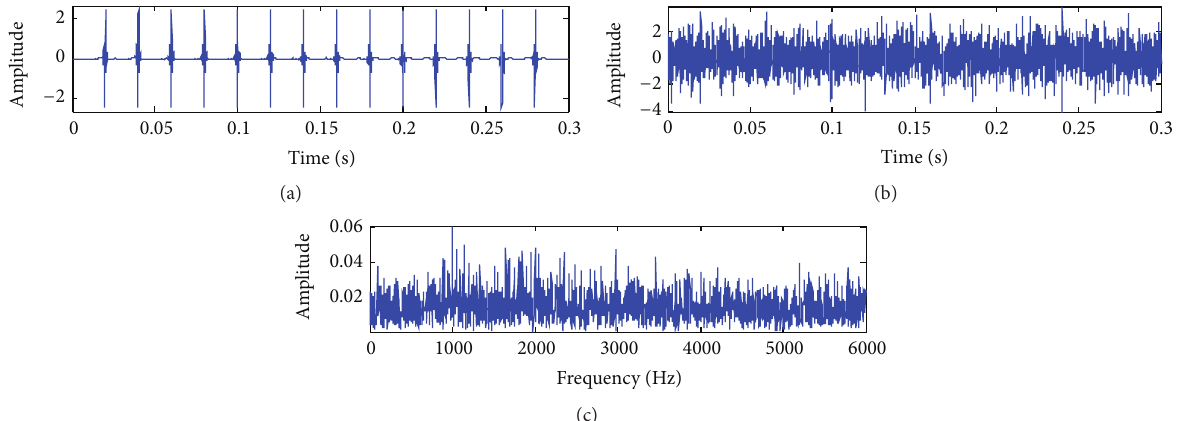
Figure 8: Simulated signal with double resonance frequency band: (a) time waveform for the pure signal; (b) waveform for the mixed signal; (c) power spectrum for the mixed signal.